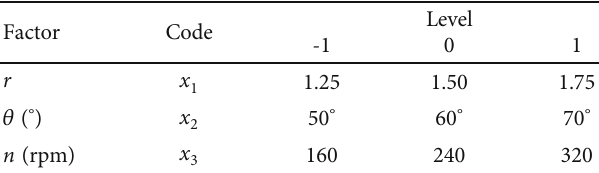
Table 4: Test scheme and result of coded test. Table 3: Factor-level coding.